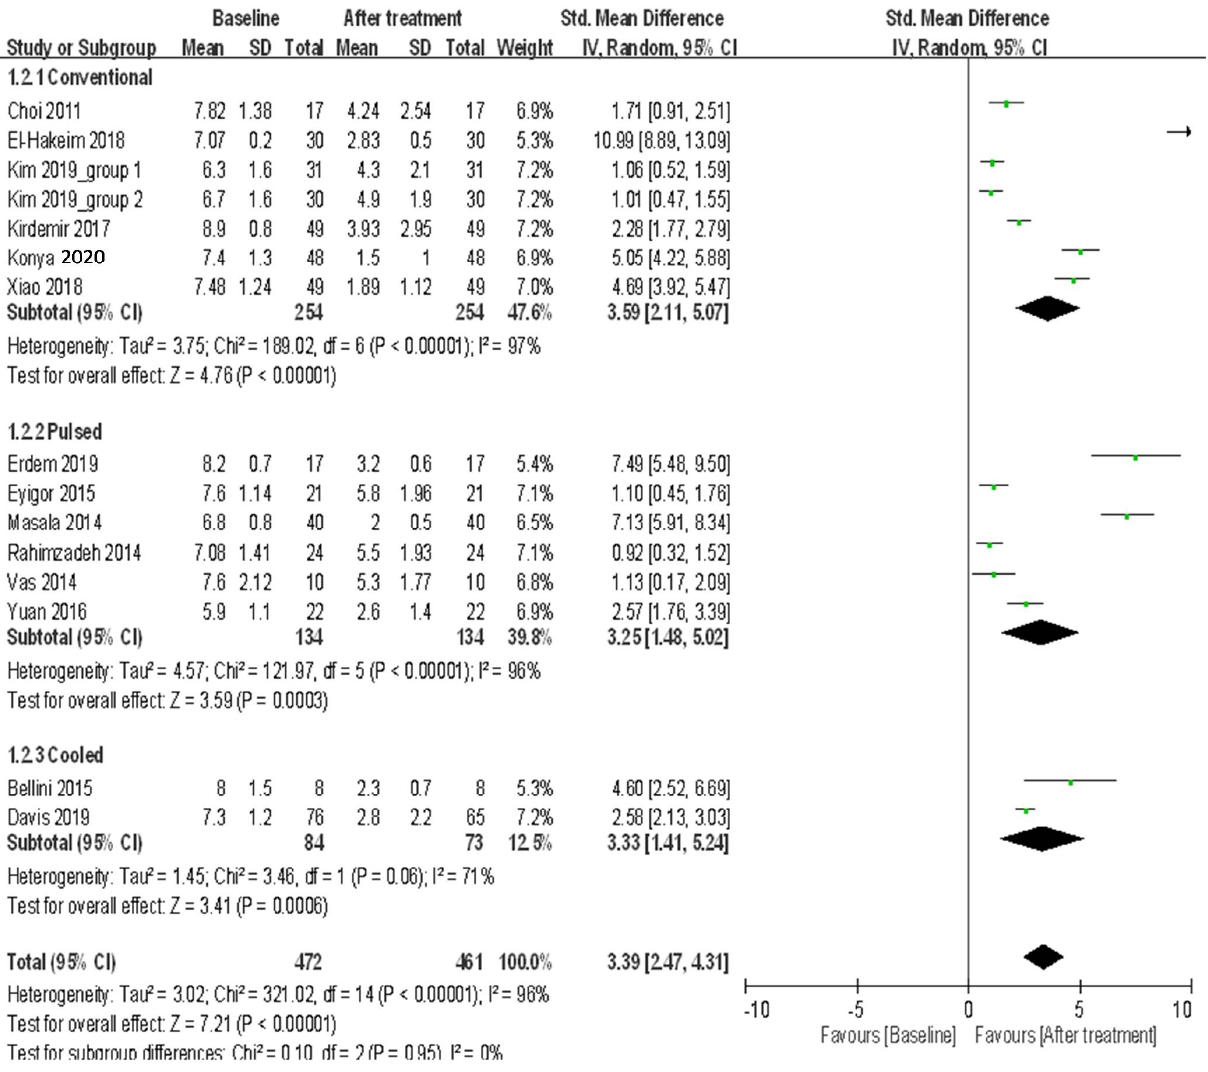
month follow-up.